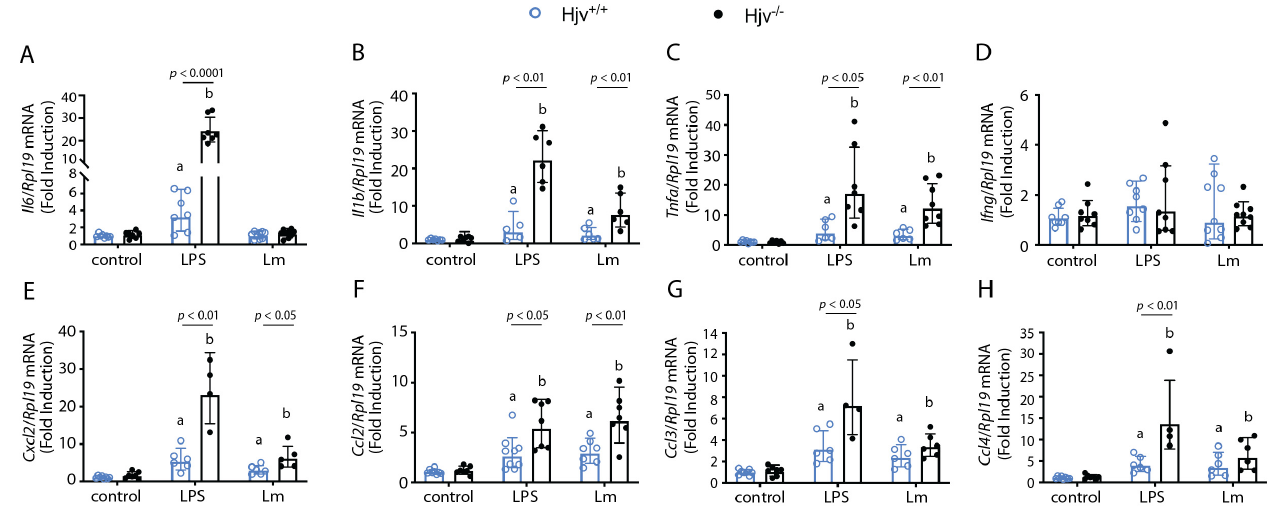
Figure 4. Cytokine expression in peritoneal lavage following acute infection with L. major . Hjv +/+ and Hjv − / − mice were injected intraperitoneally with either phosphate-buffered saline (control), the endotoxin LPS, or 10 8 L. major stationary phase parasites (Lm). Then, 6 h post-infection, the peritoneum was lavaged, and peritoneal cells were collected. RNA was extracted, reverse-transcribed, and used for qPCR analysis of ( A ) Il6 , ( B ) Il1b , ( C ) Tnfa , ( D ) Ifng , ( E ) Cxcl2 , ( F ) Ccl2 , ( G ) Ccl3 , and ( H ) Ccl4 mRNAs. Data are presented as geometric mean ± geometrical SD. Statistical differences compared with untreated Hjv +/+ or Hjv − / − mice are indicated by a or b, respectively.